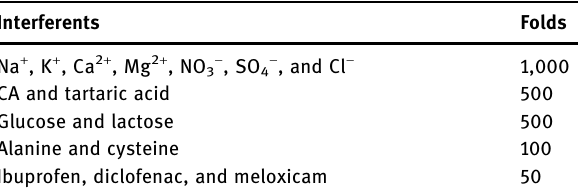
Table 2: Interference of some foreign substances for 0.5 mM of NPX Interferents